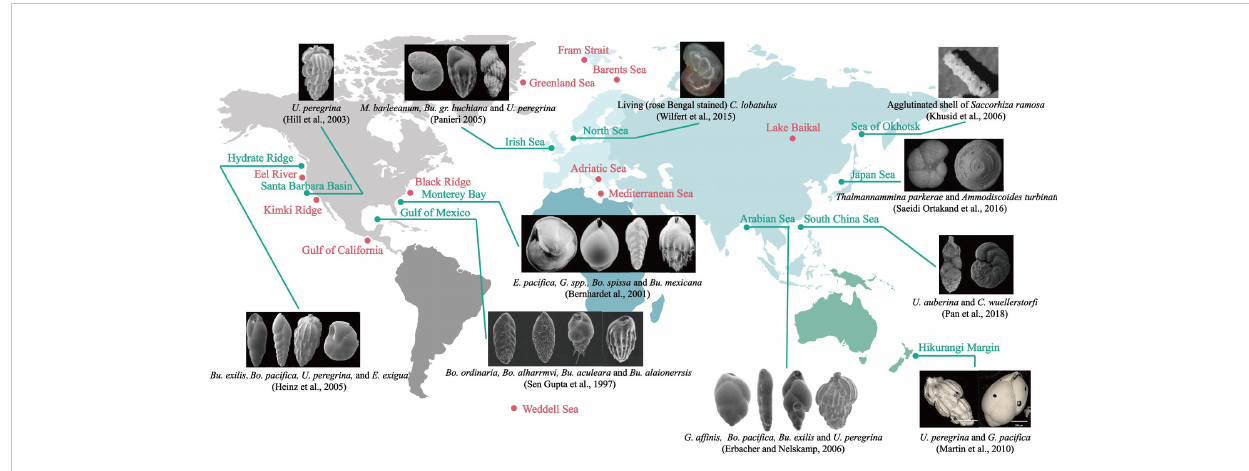
FIGURE 1 Foraminifera associated with the cold seeps in the world. The research areas, where isotopic analyses and/or species studies have already been carried out, are denoted by fi lled circles, among which green fi lled symbols indicate the sites with the community composition determined and electron microscopy images or optical microscope images of typical benthic foraminifera given next to them. As for the locations of the red dots, no foraminifera photographs are found, but it is certain that foraminifera related studies were involved. Please refer to Appendix Table 1 for relevant